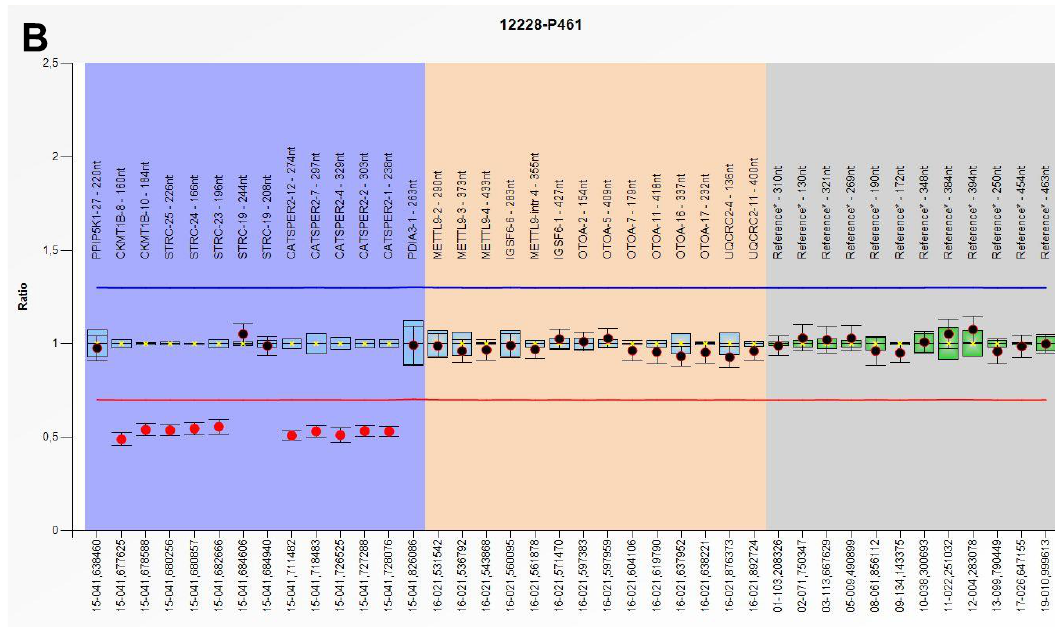
Figure 4. Complex rearrangement identified in patient 12228 in the STRC gene. ( A ) Result obtained from Decon software. The x-axis represents the exon number. Blue points reflect a normal value. Red points reflect a possible deletion for the exon. ( B ) MLPA representation of patient 12228 with the P461 salsa using the Coffalyzer.Net program (MRC Holland). Normal range: 0.7–1.3 (indicated with red and blue line, respectively).